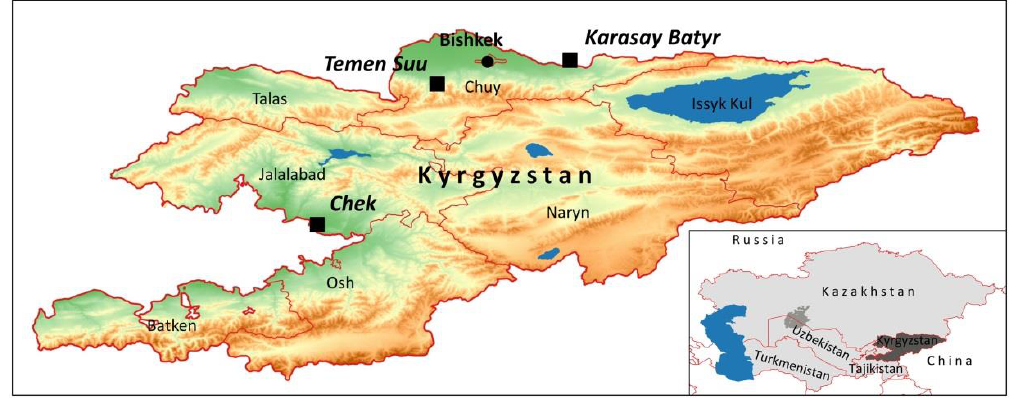
Figure 1. Location of the three study sites of Chek and Temen Suu, both in Kyrgyzstan, and Karasay Batyr, in Kazakhstan.